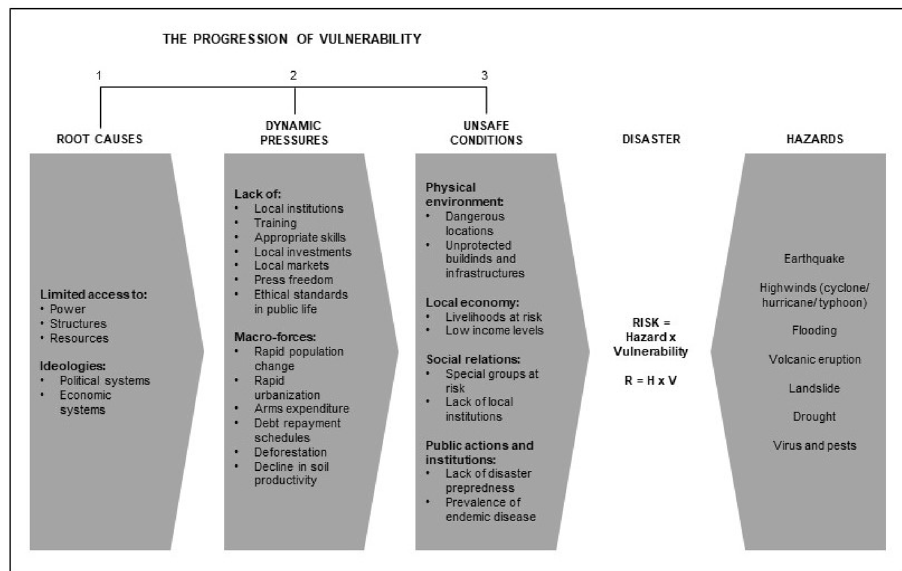
Fig. 3 The Pressure